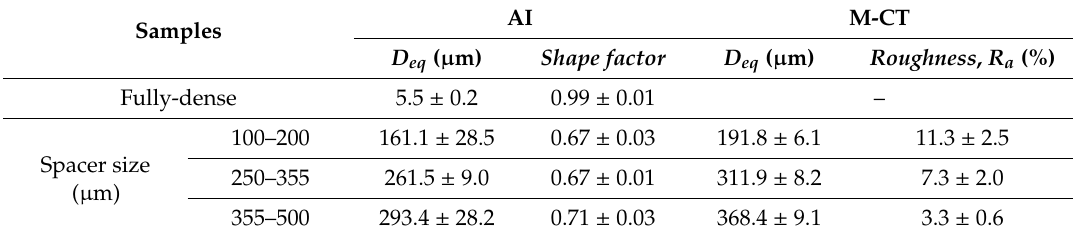
Table 2. Morphological features of the pores: size, shape factor, and roughness of the pore walls.